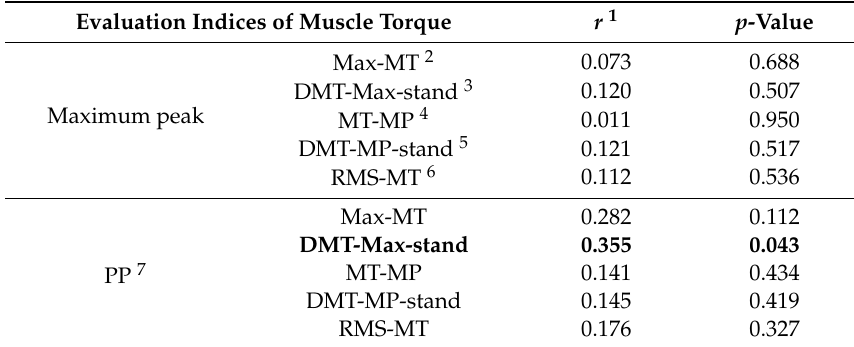
Table 3. Correlation analysis results for motion and muscle torque ( N =